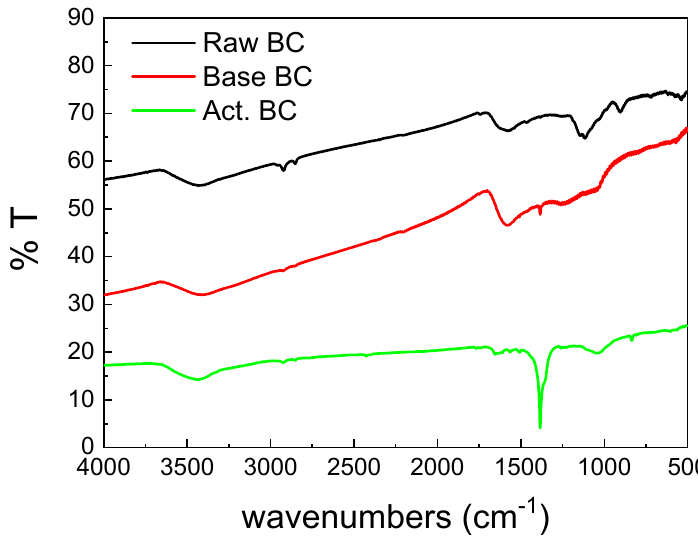
Figure 4. FTIR spectra of the studied biochars.